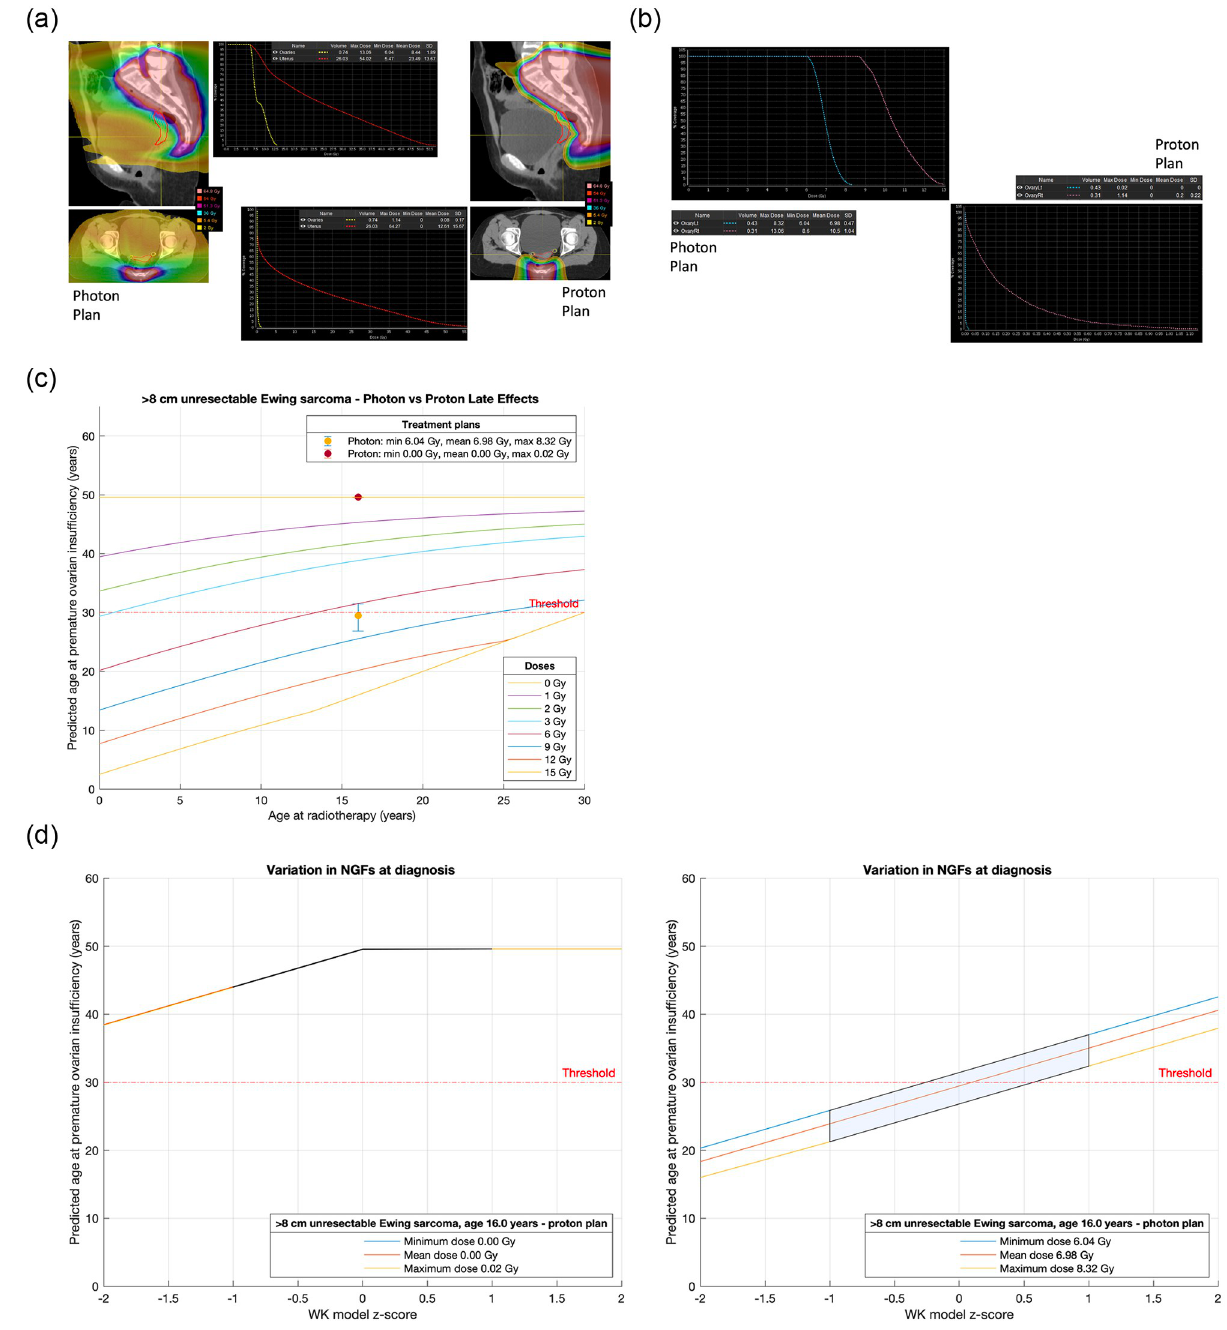
Fig 6. a . Treatment plans for Case 3, a 16-year-old with a > 8 cm unresectable Ewing sarcoma. b . Analysis and comparison of dose received by each ovary for Case 3, a 16-year-old with a > 8 cm unresectable Ewing sarcoma. c . Comparison of treatment plans assuming average NGF population at age of treatment (i.e., z-score = 0) for Case 3, a 16-year-old with a > 8 cm unresectable Ewing sarcoma. Dots are predicted age at menopause after mean dose. Fertility window ranges between predicted ages for minimum & maximum dose. LD 50 is estimated to be 2 Gy. Dose is to the least affected ovary. d . Comparison of treatment plans for Case 3, a 16-year-old with a > 8 cm unresectable Ewing sarcoma that incorporate uncertainty due to variation in NGF population at birth. (Or, equivalently, variation in ages at menopause). The z-score 0 values are the same ranges as reported in Fig 6. 68% of the population are expected to fall in the left-to-right shaded